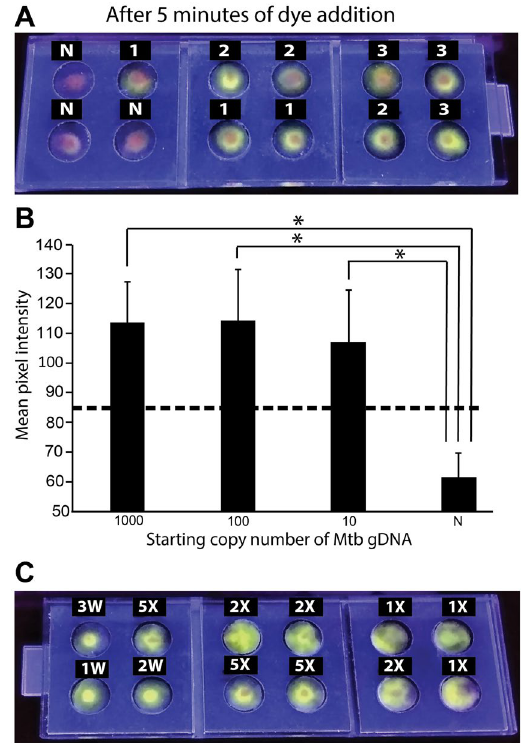
Figure 6. LAMP in FLIPP-NAAT from dry-stored reagents. ( A ) End-point imaging of the FLIPP-NAAT device after 5 minutes of addition of SYBR green I dye. Numbers on top of each reaction zone indicate log 10 of starting copy number. N – no template control. ( B ) Mean pixel intensity of the green color from all starting copy numbers was statistically higher ( * P < 0.05; N = 3) from that of no template control. The dashed line represents the threshold value of ( µ N + 3 σ N ). Samples with intensity below the threshold were considered as TB negative while samples with green color intensity above the threshold were considered as TB positive. ( C ) LAMP in FLIPP-NAAT from dry-stored reagents and rehydration with mock sputum. Each reaction zone had 100 copies of Mtb gDNA as the starting template. The markings on top of each of the reaction zone indicate the dilution of mock sputum used for rehydration. 3 W, 2 W, 1 W – reaction set-up with template suspended in water containing 1000, 100 and 10 copies of Mtb gDNA respectively, as positive controls. All reactions worked despite the presence of the complex sputum